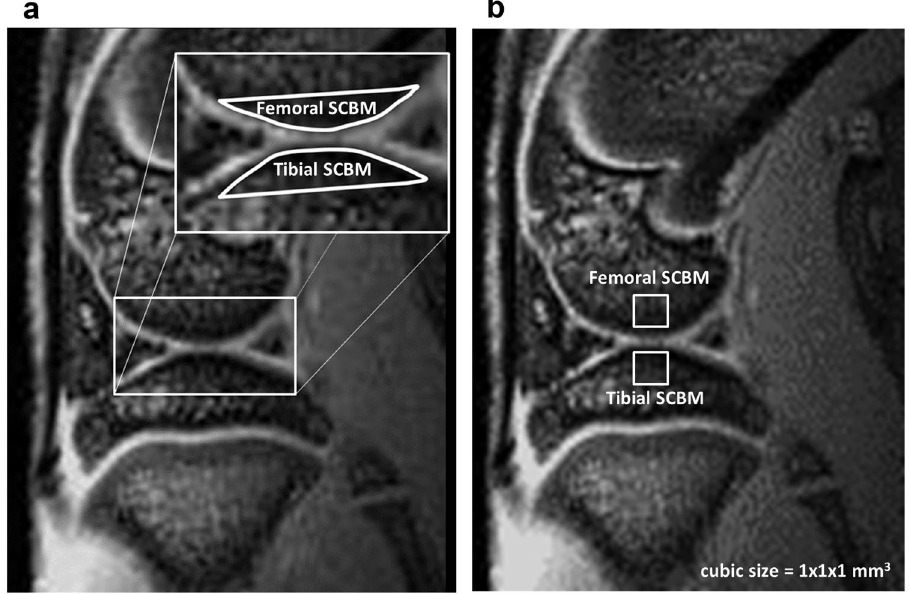
Figure 7. ROIs in the knee subchondral bone marrow. ( a ) ROIs (white) in the femoral and tibial subchondral bone marrow were manually selected using the DCE-MRI first-frame and MRI T2 * first-echo sagittal image. ( b ) MR spectroscopy values were measured using a PRESS sequence, with two cube-shaped ROIs (1 mm each side) positioned at the center of the lateral and medial parts of the femoral and tibial subchondral bone marrow,